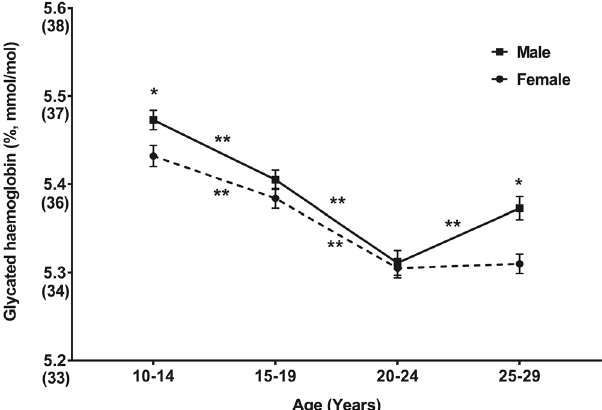
Figure 2. Difference in Glycated Haemoglobin (Weighted Mean and Standard Error) According to Age Group and Sex. ( * P < 0.05 between sex, ** P < 0.05 between adjacent age